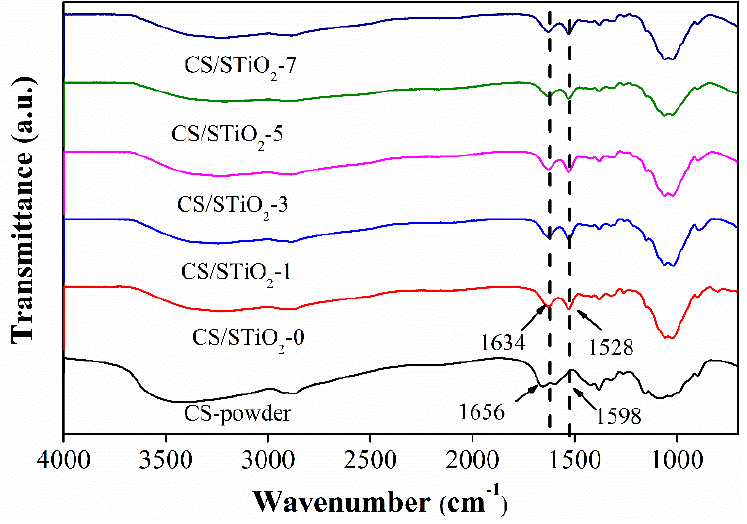
Figure 3. The FTIR spectra of CS control and CS/STiO 2 nanocomposite membranes .